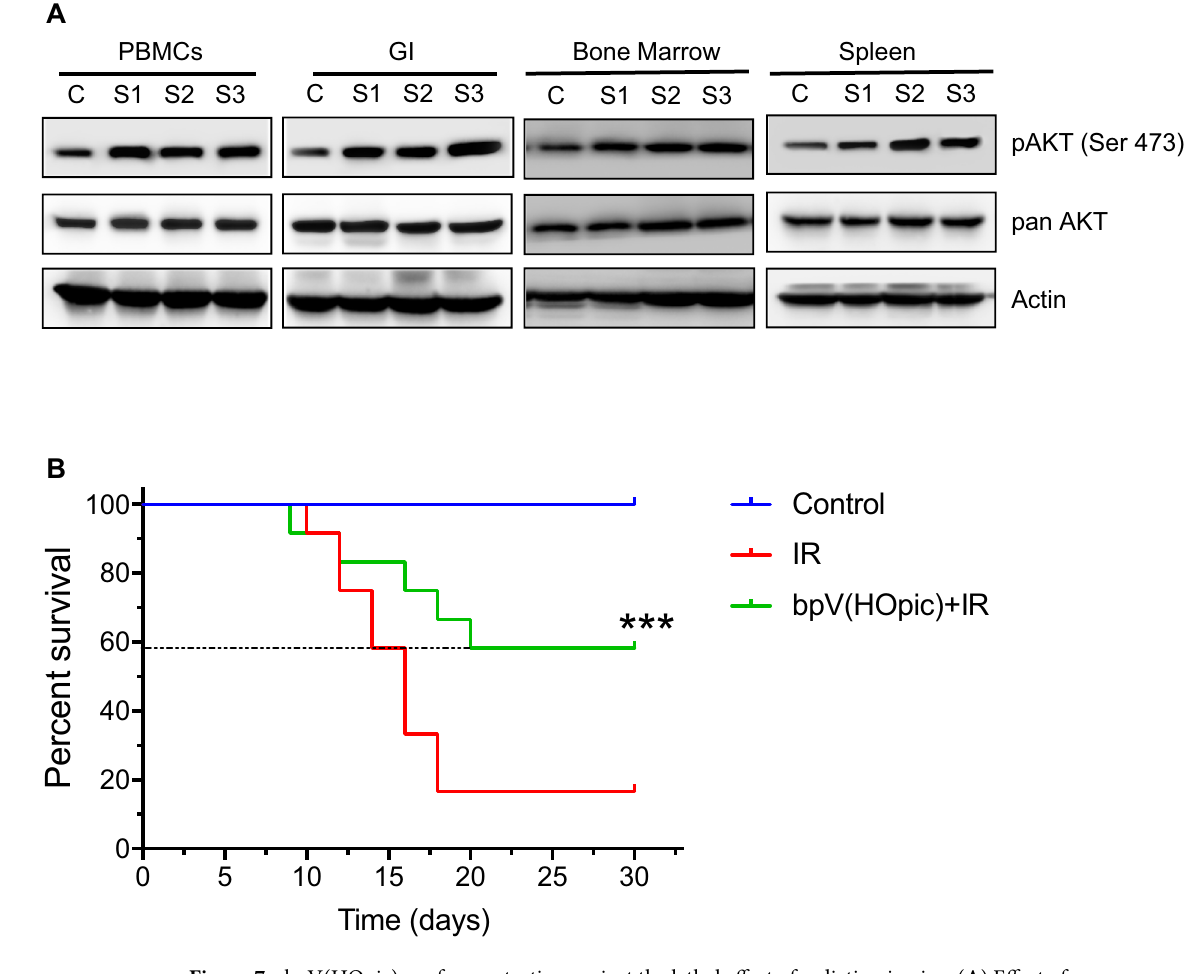
Figure 7. bpV(HOpic) confers protection against the lethal effect of radiation in vivo. ( A ) Effect of bpV(HOpic) on the induction of AKT signaling in vivo. Indicated tissues [Peripheral blood mononuclear cells (PBMCs); Gastro-Intestinal (GI); Bone Marrow; and Spleen] were harvested 4 h post 1 mg/Kg body weight bpV(HOpic) administration (n = 3 per group), intraperitoneally and 10% tissue homogenate was lysed and subjected to immunoblotting for pAKT and AKT levels. Lane C is a sample from control animal; Lanes S1– S3 are samples from animals 1–3. ( B ) Effect of bpV(HOpic) pretreatment (1 mg/Kg body weight; IP) on the survival of whole-body irradiated C57BL/6 mice. Statistical significance was measured using log-rank test. n = 12 per group, *** p <